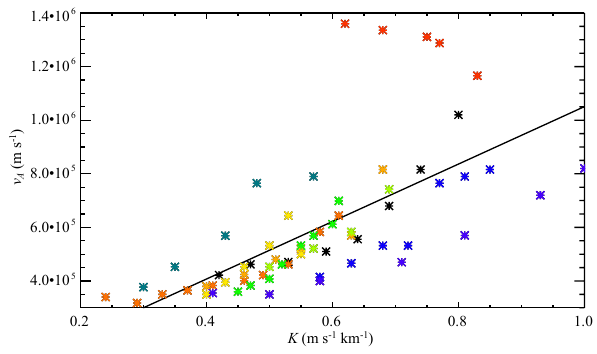
Figure 11. Scatter plot summarizing the analysis results. The horizontal axis is gradient, K , of the lines of best fit of f against N at each hour for the IAR resonance features. The vertical axis is Alfvén velocity calculated directly from the electron density given by the f o F2 hourly data, assuming that the mean ion mass in the IAR is given by the mean in the F region ~ 24.7 a.m.u. The gradient of the least squares regression line through these points gives 2 L , where L = 530 km is the mean IAR scale height for all of the 10 intervals of IAR resonance features that were analyzed in detail. The colour of the stars varies according to date, going from black-red-yellow-green-blue with chronological order.